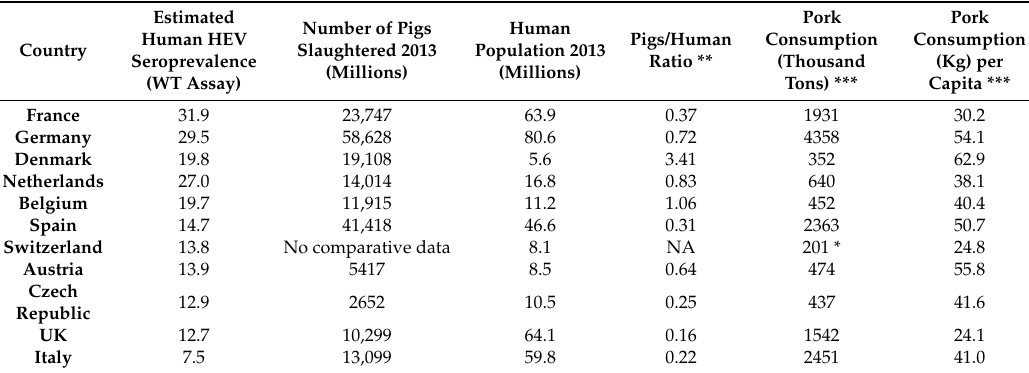
Table 5. HEV seroprevalence and pig